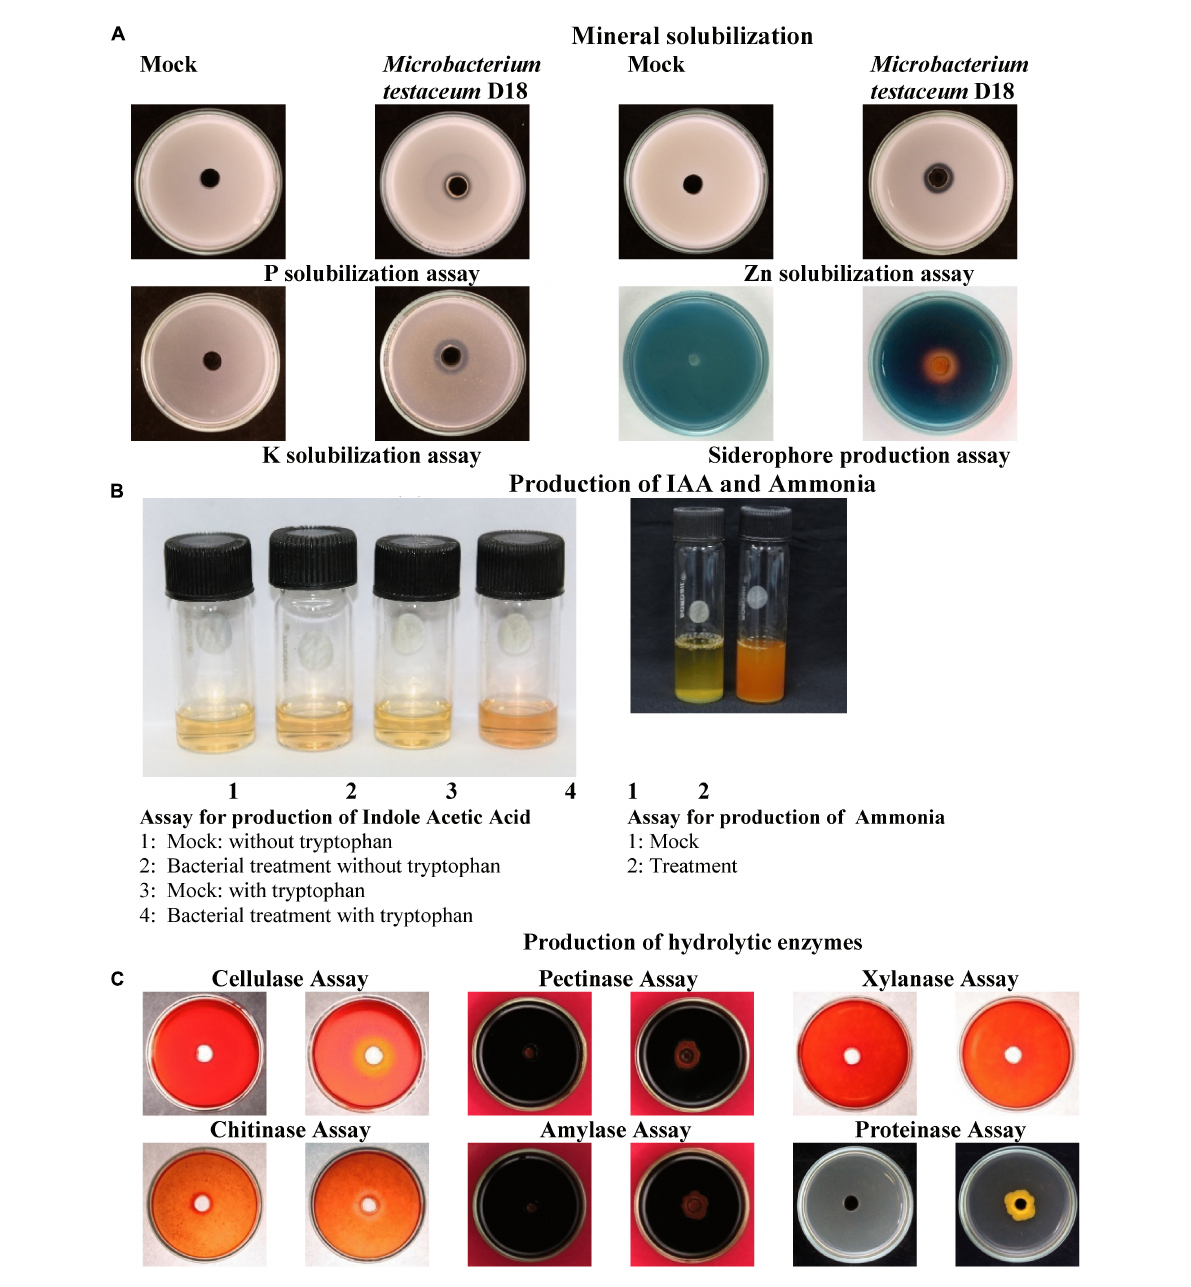
FIGURE3 Plant probiotic features of M. testaceum D18. (A) Mineral solubilization assays. (B) Production of IAA and Ammonia. (C) Production of hydrolytic enzymes.